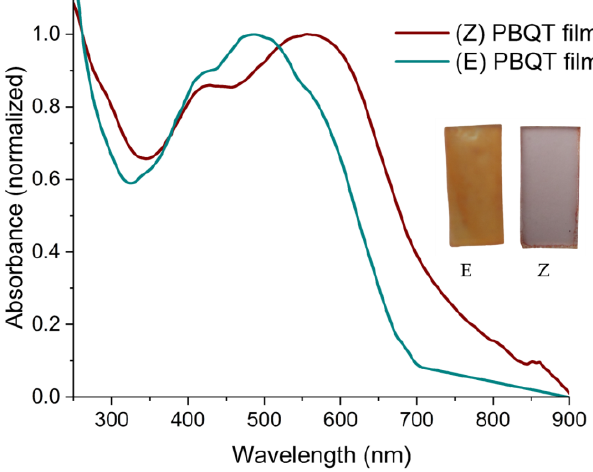
Figure 6. Normalized absorption spectra of PBQT in film. Table 2. Absorption optical properties in solution and film of the polymer PBQT .